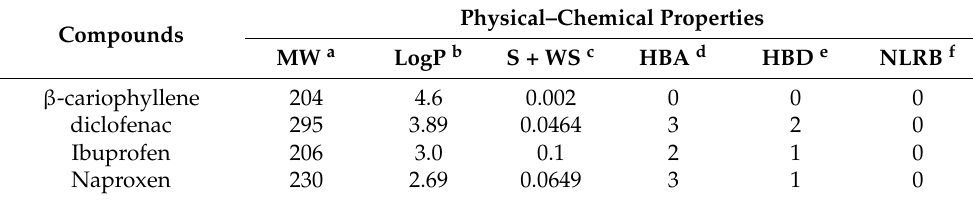
Table 7. Physical–chemical parameters of β-caryophyllene compared to commercial anti-inflammatories drugs (diclofenac, ibuprofen, and naproxen). a Molecular weight (Da); b Partition coefficient in a logarithmic scale; c Native water solubility (mg/mL); d Number of hydrogen bond acceptor (HBA); e Number of hydrogen bond donor (HBD); f Number of Lipinski’s rules broken (NLRB).